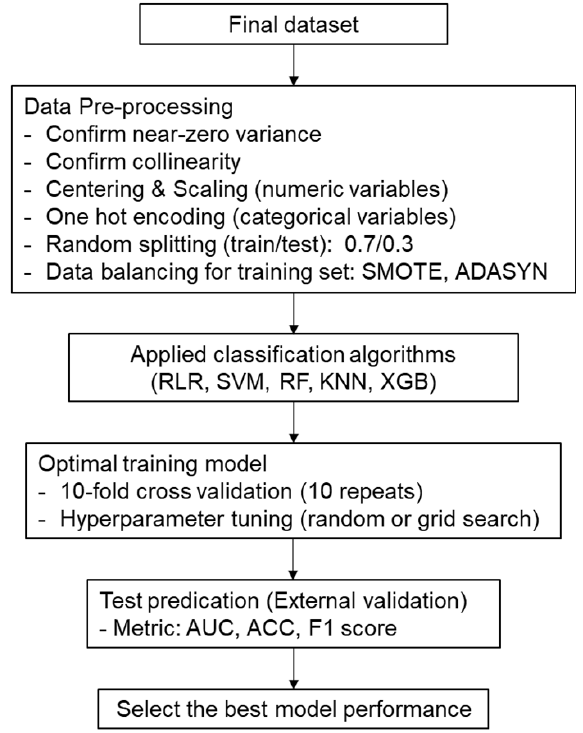
Figure 2. Entire machine learning modeling process for this study. SMOTE, synthetic minority oversampling technique; ADASYN, adaptive synthetic; RLR, regularized logistic regression; SVM, support vector machines; RF, random forest; KNN, k-nearest neighbors; XGB, extreme gradient boosting; AUC, area under the receiver operating characteristic curve; ACC, accuracy.